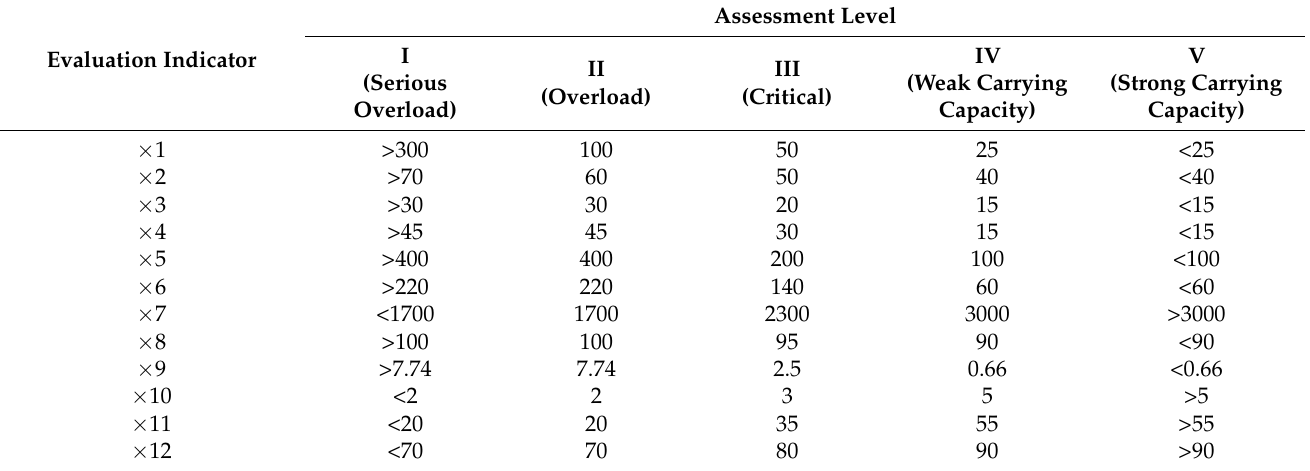
Table 2. Evaluation index grade